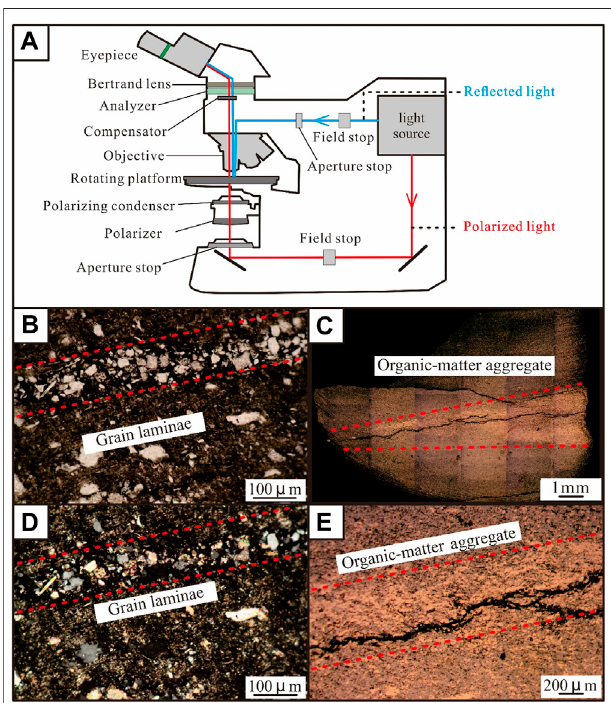
FIGURE 4 | Principle of optical microscope. (A) Structure of polarized and re fl ected light microscopes; (B) Grain and crystal lamina in N228-57 (Longmaxi Formation, 3,420.96) at single polarization; (C) Stitching picture of re fl ected light of shale (PS1-06) polished by argon ion; (D) Grain laminae in N228-57 at orthogonal polarization; and (E) Organic matter aggregate underare fl ectedlightmicroscope(PS1-06,LongmaxiFormation,5,957.2 m).